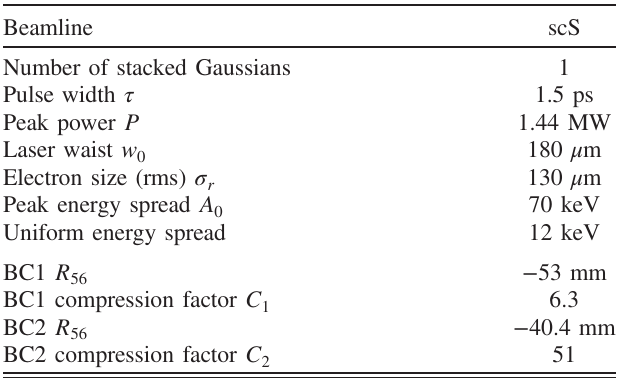
TABLE II. Laser heater shaping parameters to generate a single high-current spike at the LCLS-II scS beamline.